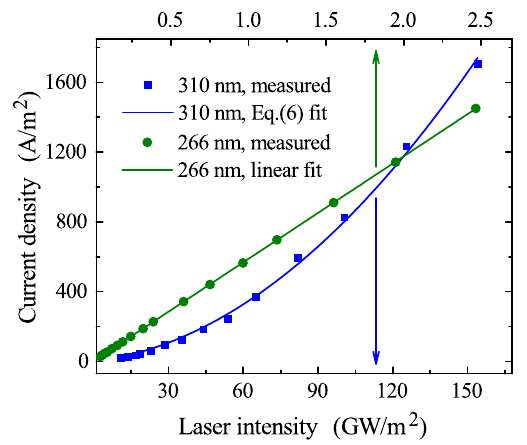
FIG. 3. Current density, charge of a single pulse divided by the product of the laser spot area and the pulse duration (FWHM), as a function of laser intensity for the wavelength of 266 nm (4.66 eV) and 310 nm (4.00